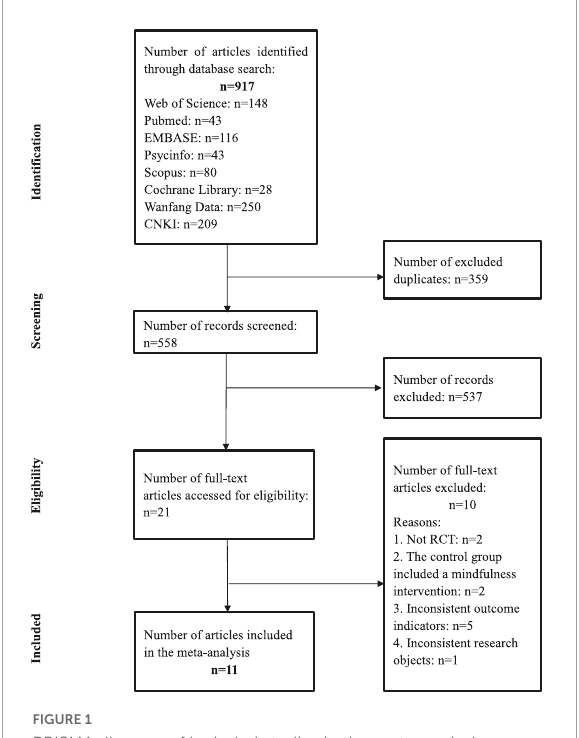
FIGURE1 PRISMA diagram of included studies in the